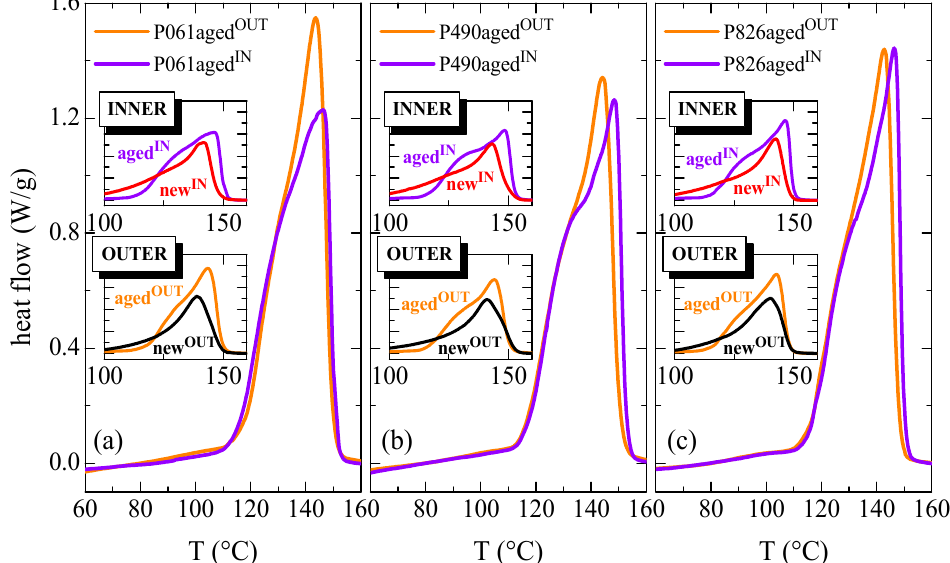
Figure 4. First DSC melting curves for the inner and the outer parts in the different aged pipes: ( a ) P061; ( b ) P490; and ( c ) P826. The insets show for both the inner and outer sections the comparison of results between aged and new pipes.